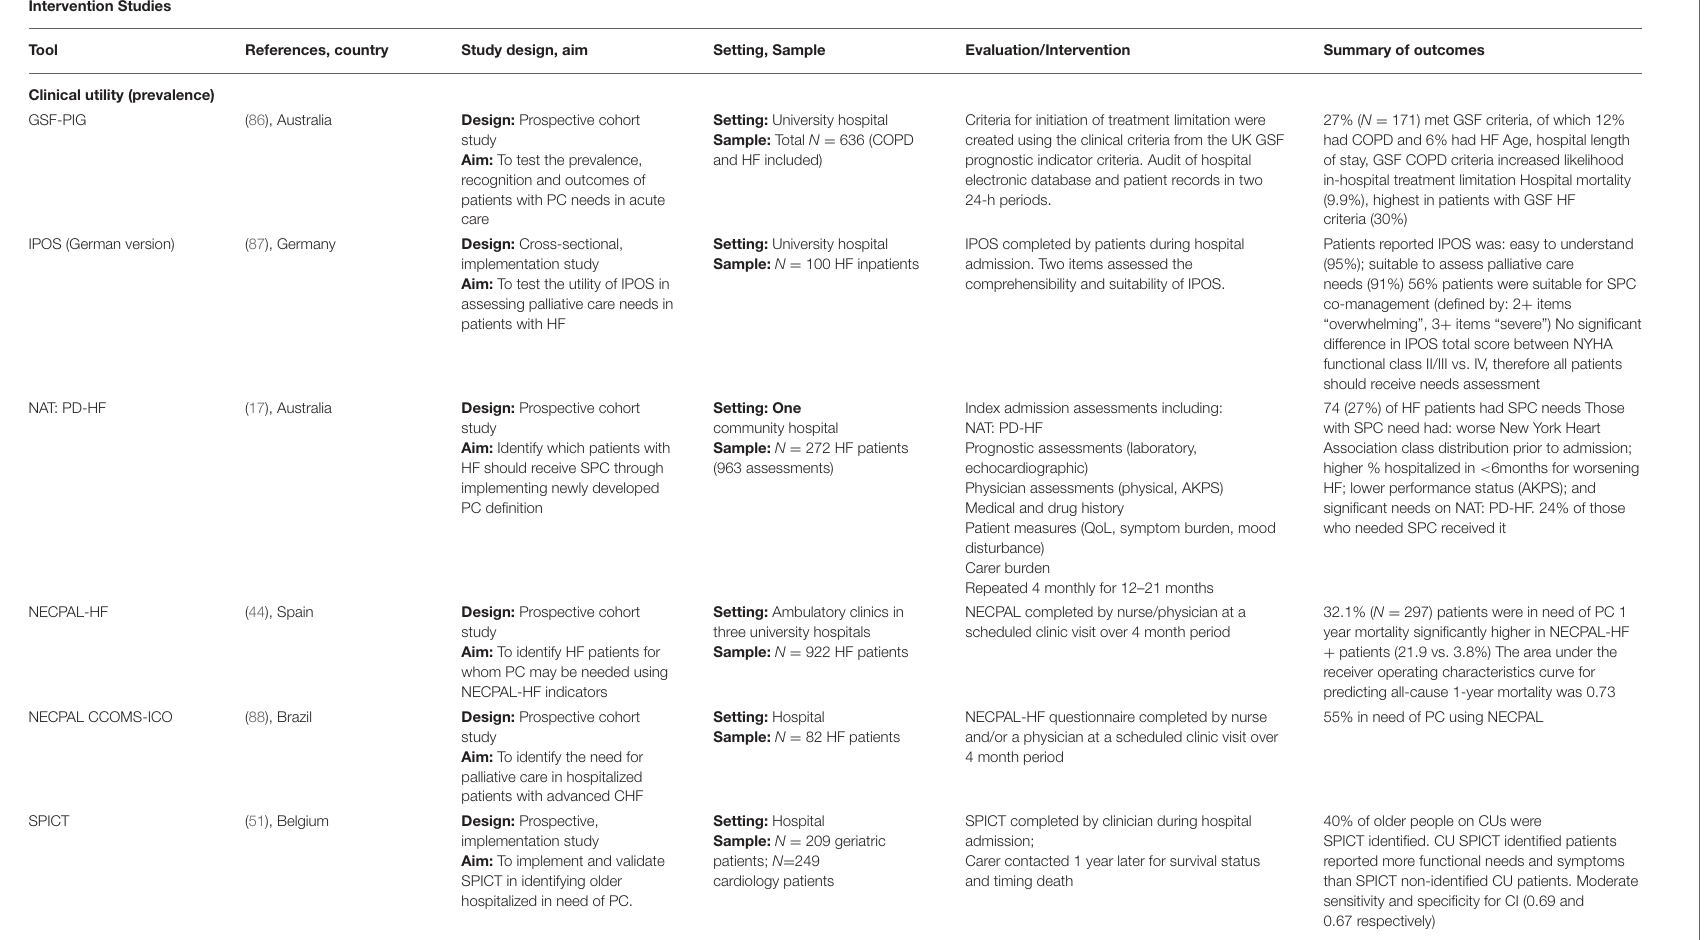
TABLE 2 | Summary of studies summarizing the implementation of tools to identify and assess palliative care needs. Intervention